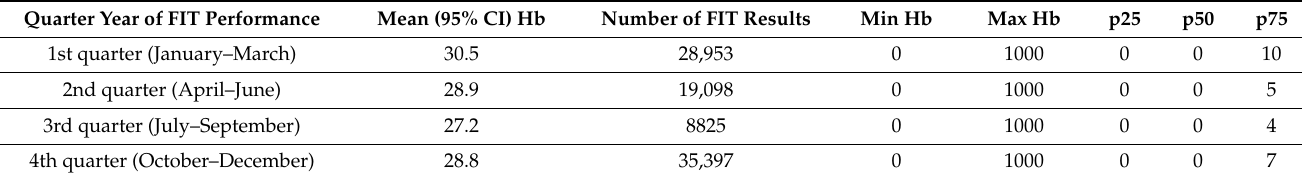
Table 3. Logistic regression of the probability of positive screening tests by temperature and hu- midity (95% CI).